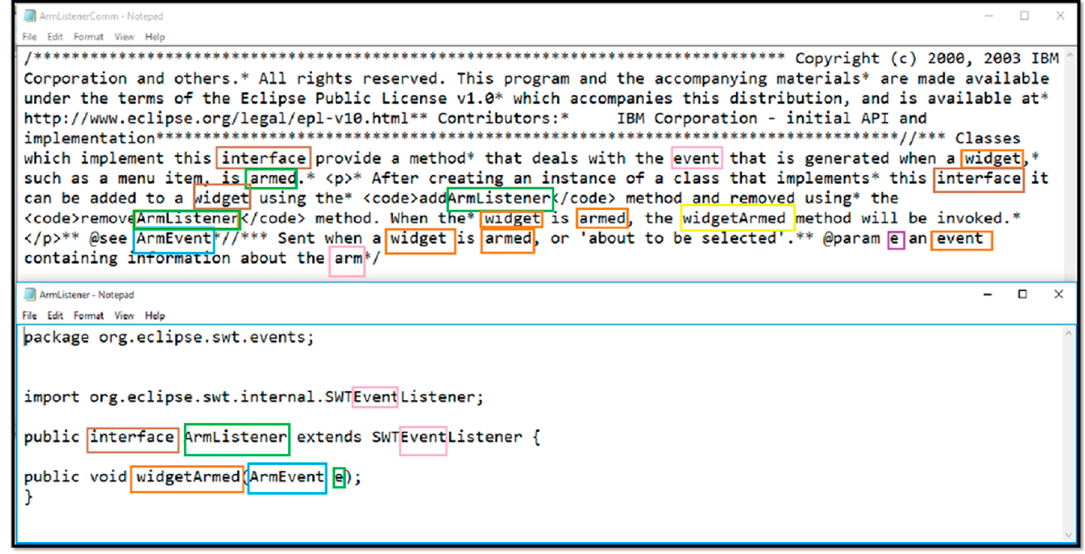
Figure 4. The shared terms between code body and comment in the source code file “ArmListener”.